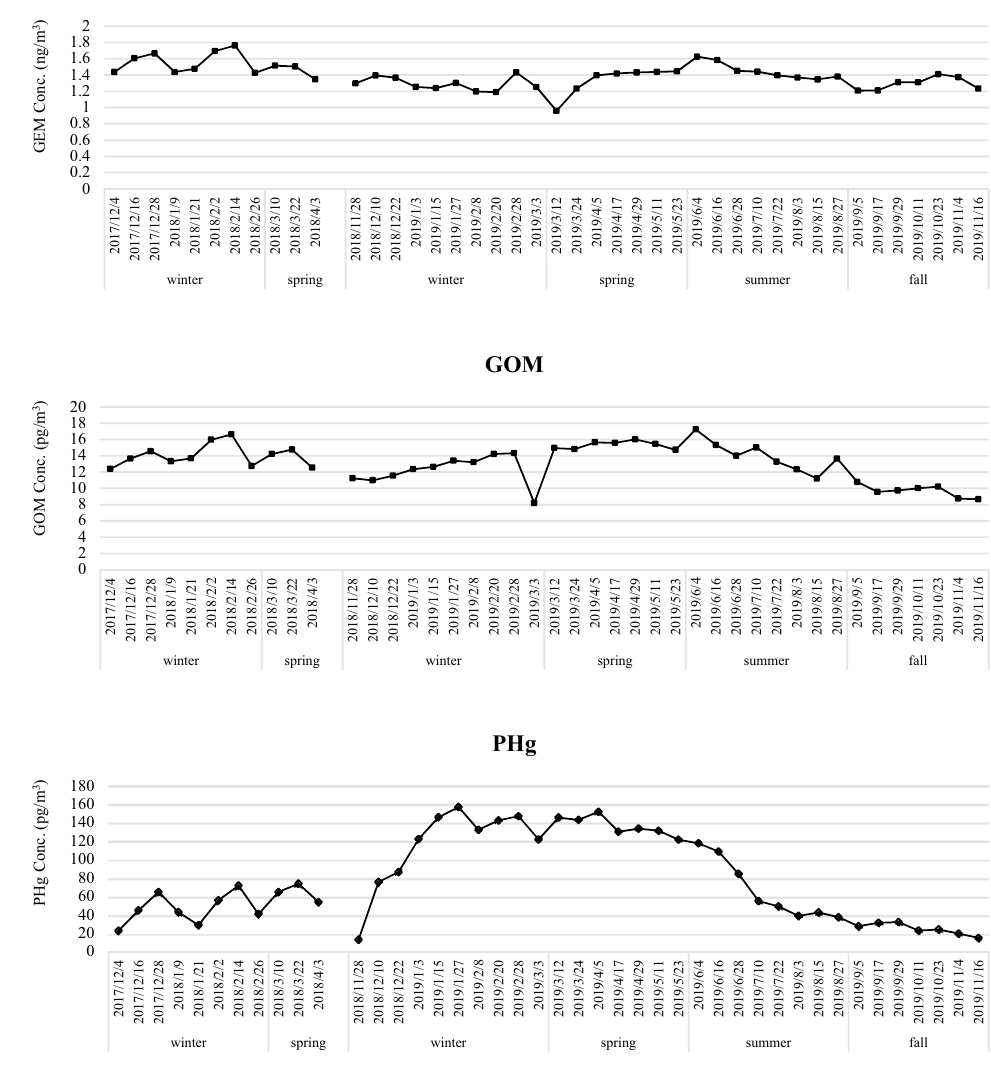
Figure 3. Temporal variation of atmospheric speciated mercury concentration for regular sampling conducted at the Taiping Island in the South China